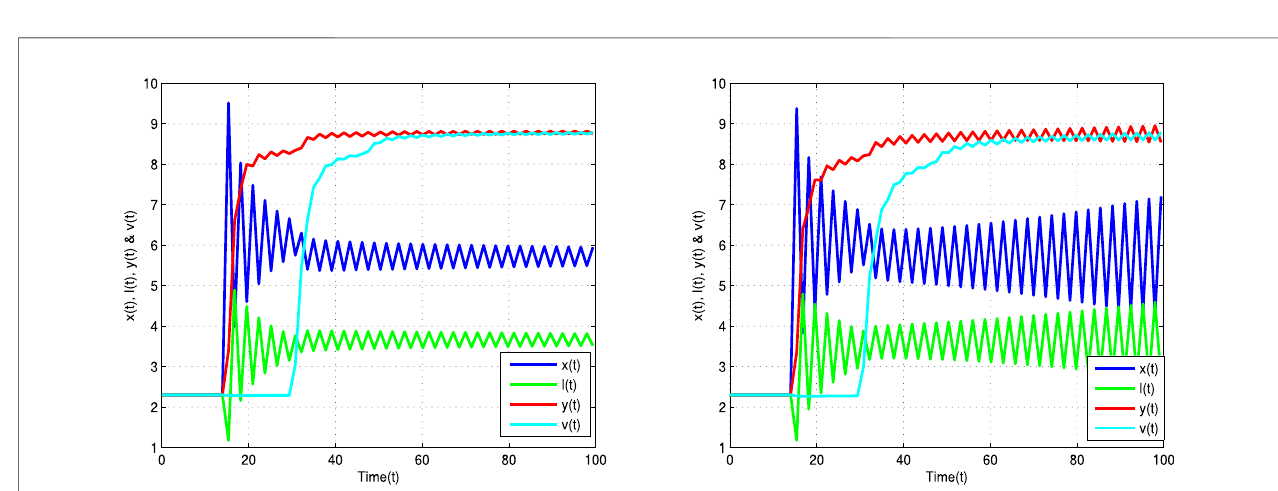
FIGURE1| Timetrajectoriesforuninfectedcells x ( t ),latentlyinfectedcells l ( t ),infectedcells y ( t ),viruses v ( t ),andantibodies w ( t )of Eq.2 with α (cid:2) 1 (leftbanner) and α (cid:2) 0.9 (right banner) and R (cid:2) 0 . 93 < 1. 0